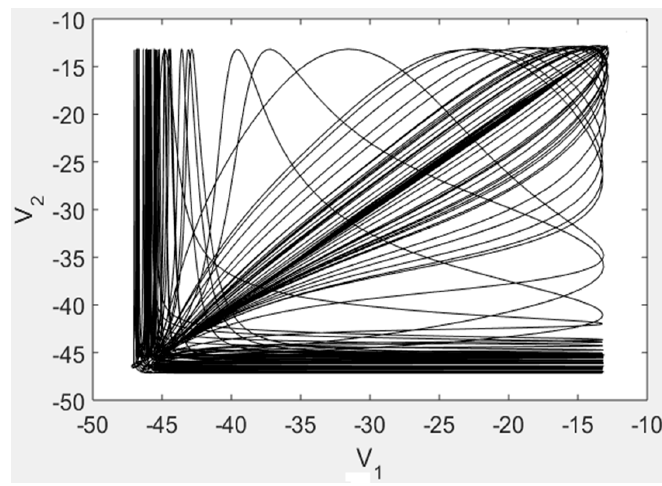
Figure 2. Locus (V 1 , V 2 ) when H syn = 0.